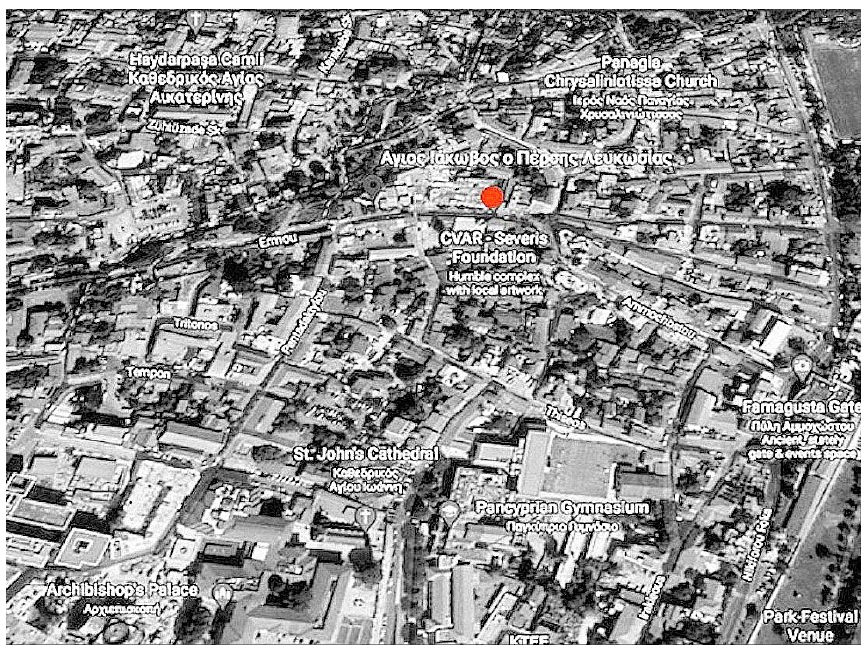
Figure 1. The location of Ayios Iakovos in modern-day Nicosia. 2021.